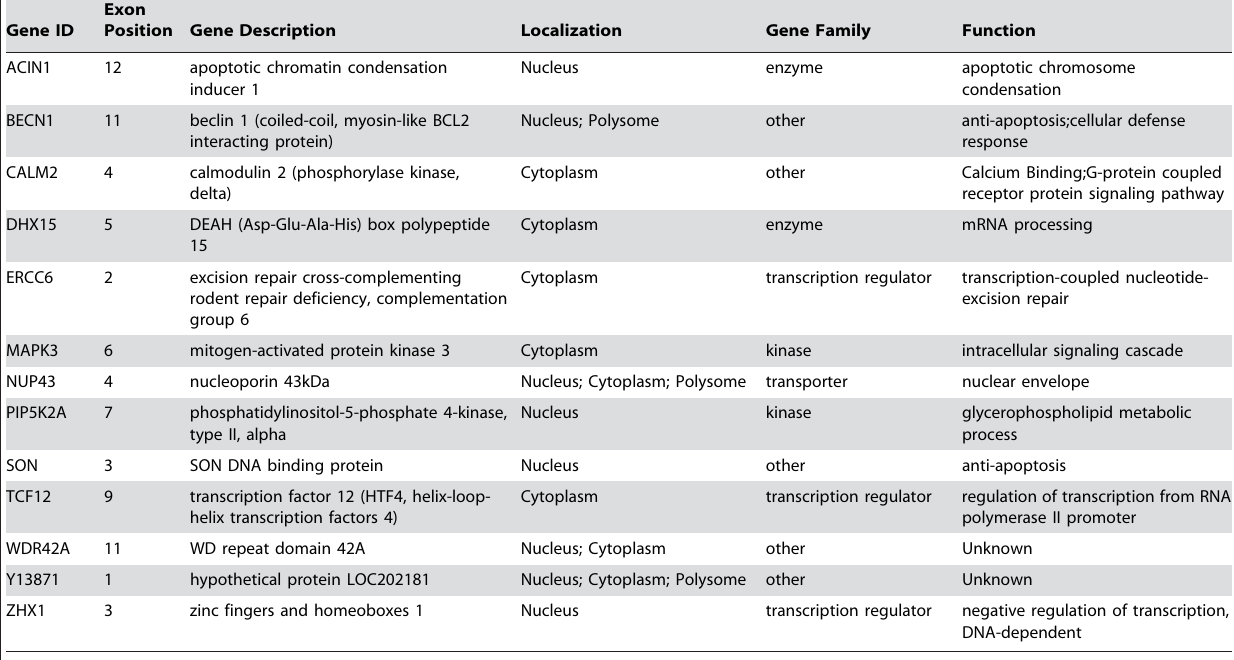
Table 1. Annotation of alternative cassette exons bound by SF2/ASF.